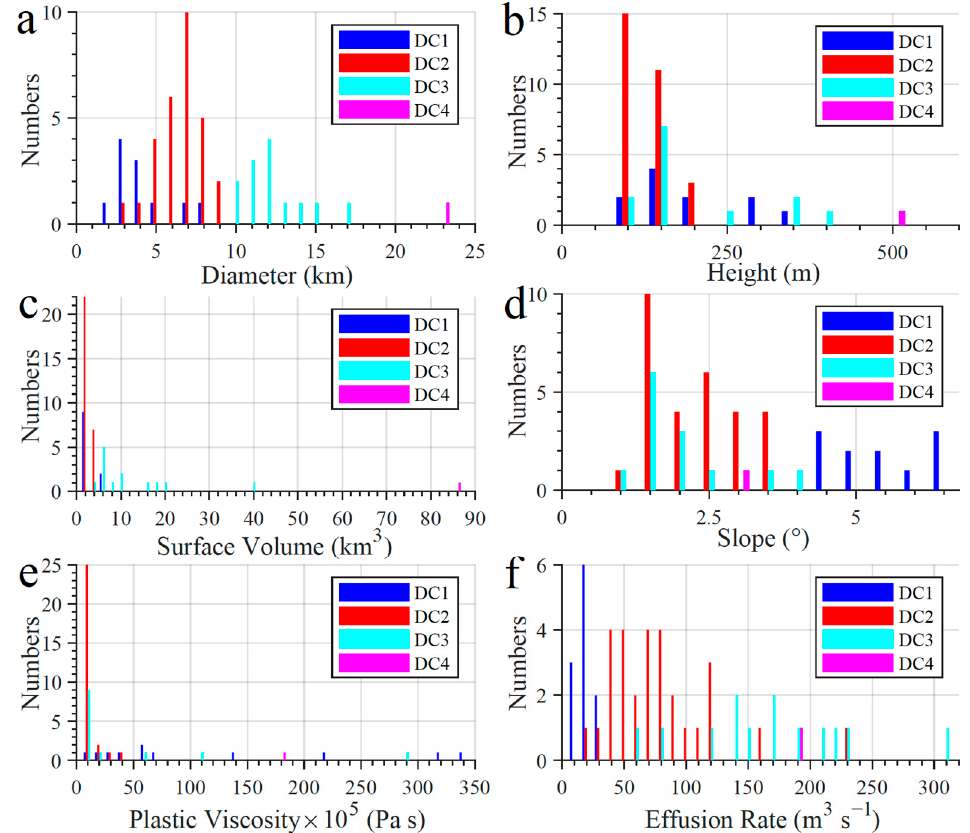
Figure 6. Histograms of ( a ) diameter, ( b ) height, ( c ) surface volume, ( d ) average flank slope, ( e ) plastic viscosity, and ( f ) lava effusion rate for each dome in DC1 to DC4.